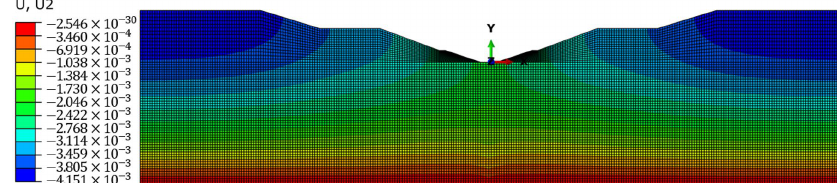
Figure 12. Canal settlement nephogram when t = 5 years.